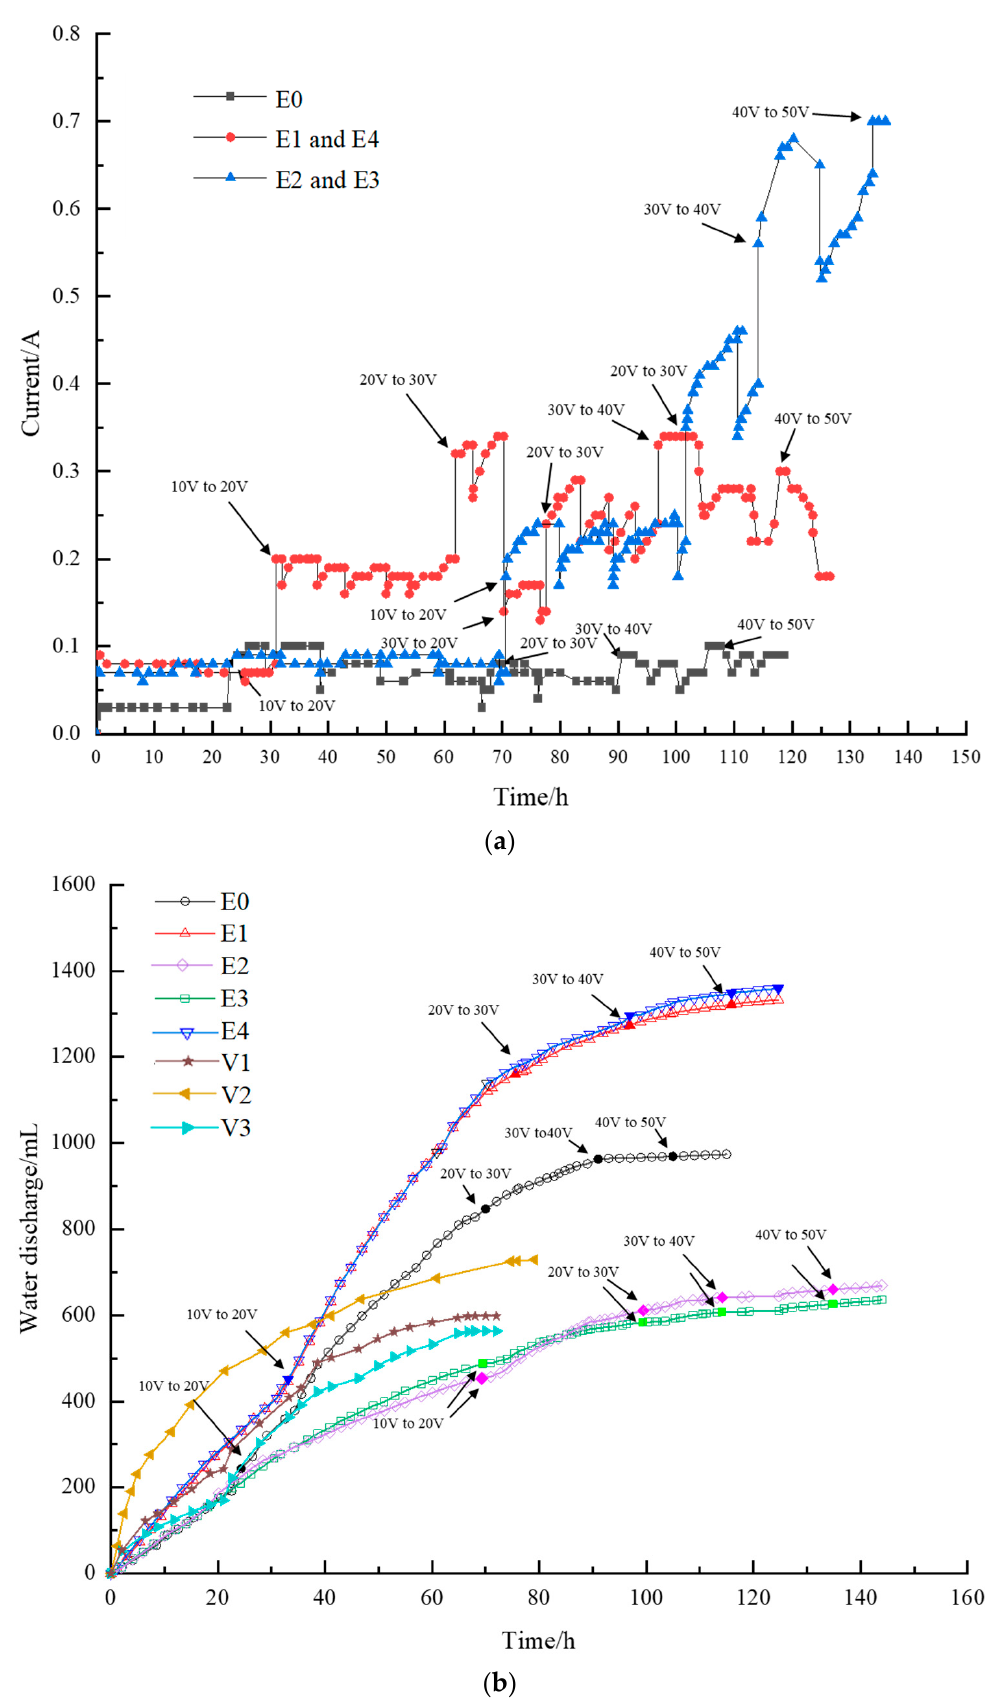
Figure 5. ( a ) Current variation, and ( b ) water discharge.